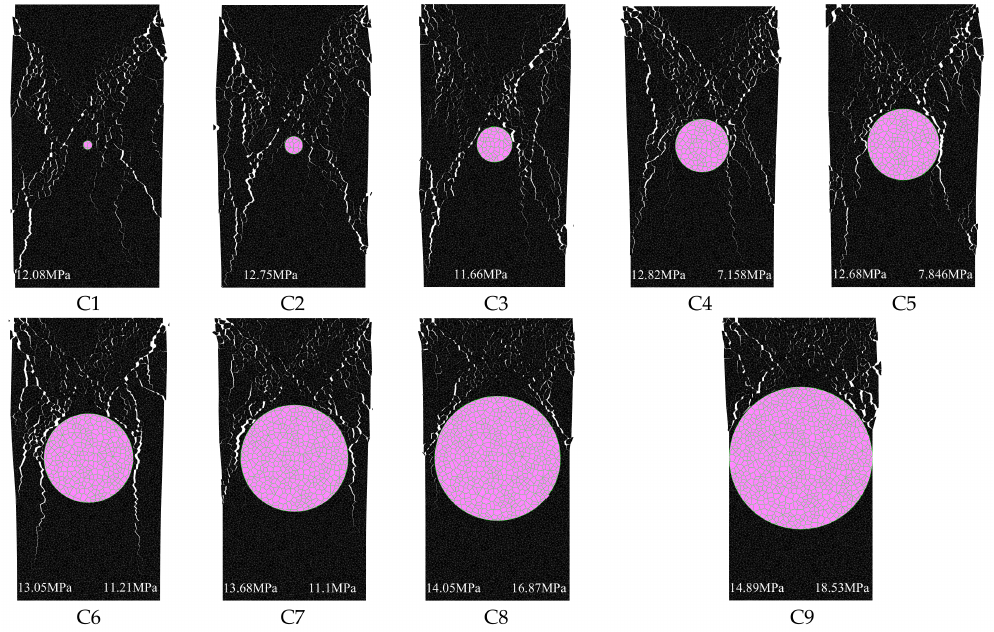
Figure 14. Crack pattern of mineral circle size after sample is broken.